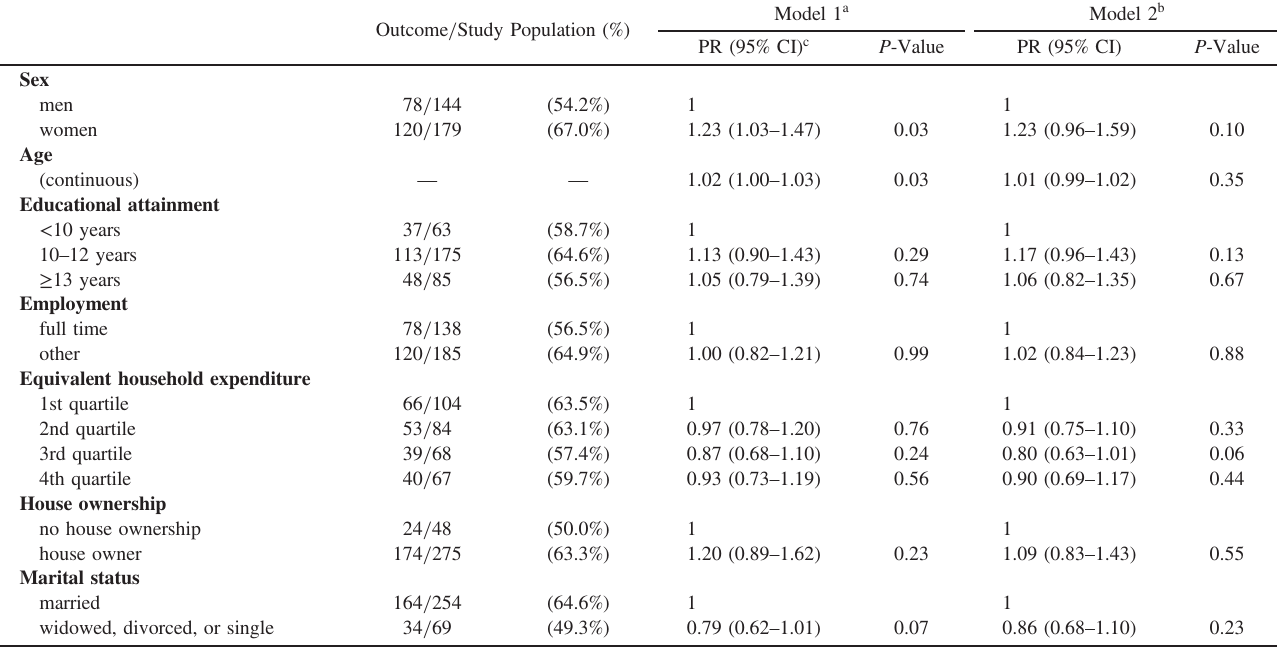
Table 2. Relationships among participation in health examinations and related factors in the 40 – 64 years group: NIPPON DATA2010